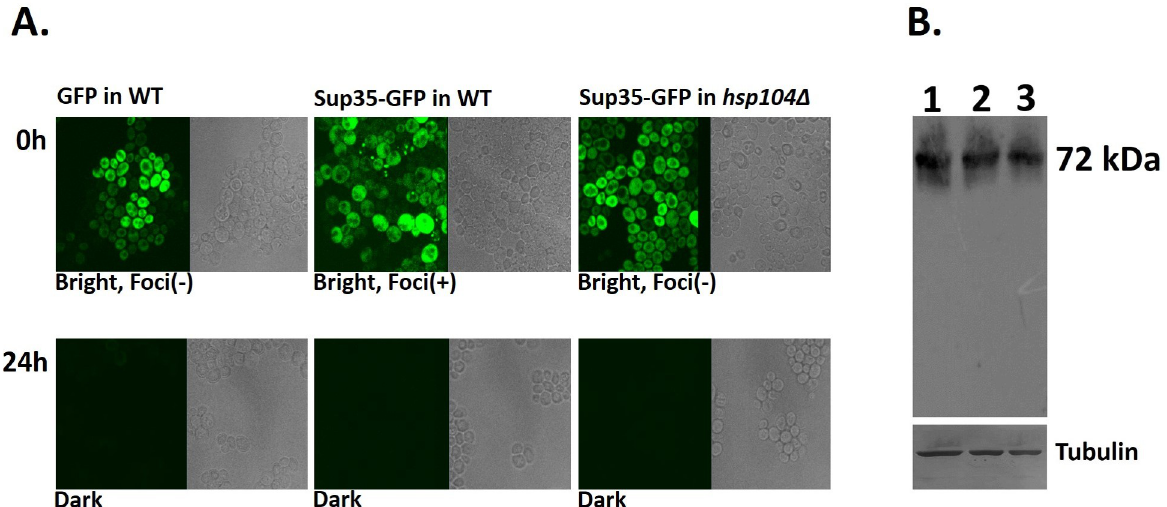
Fig 3. (A) Effects of stress on Sup35-GFP protein. Sup35-GFP in wild type and hsp104 Δ yeast cells when observed under the confocal microscope under no stress (t = 0 hours). Sup35-GFP in wild type and hsp104 Δ cells after 24 hours incubation in the presence of 5mM guanidium hydrochloride. (B) Expression of Sup35-GFP under stress conditions. Sup35-GFP protein in unstressed cells (lane 1), in cells exposed to 5mM guanidium hydrochloride for 24 hours (lane 2), and in cells exposed to 5mM guanidium hydrochloride and 100mM trehalose for 24 hours (lane 3).